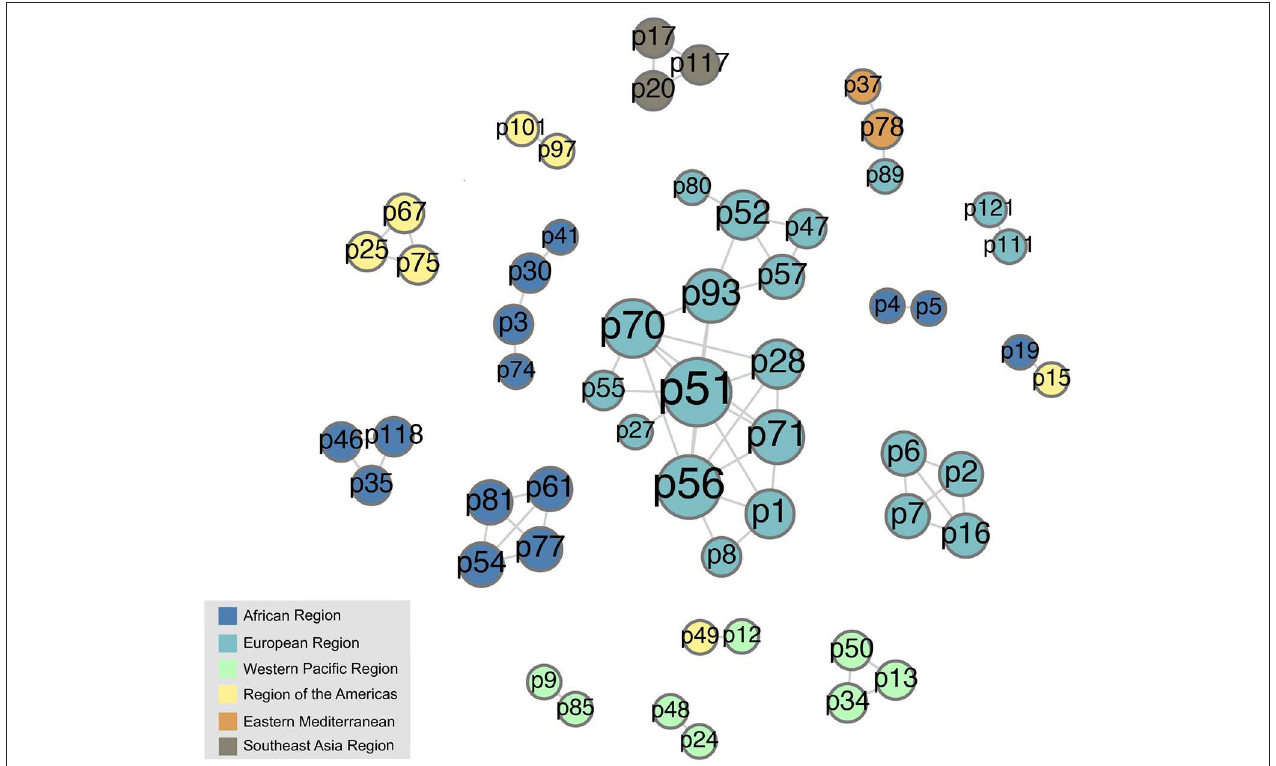
FIGURE 10 | Network of 2013–2019 workshop attendees who coauthored publications with other attendees during 2014–2019. Note that this graph includes all workshop participants in this category as of 2019, so some links may reflect papers that were authored before the individuals in question actually attended a workshop. Nodes are sized by degree (i.e., number of publication collaborators).